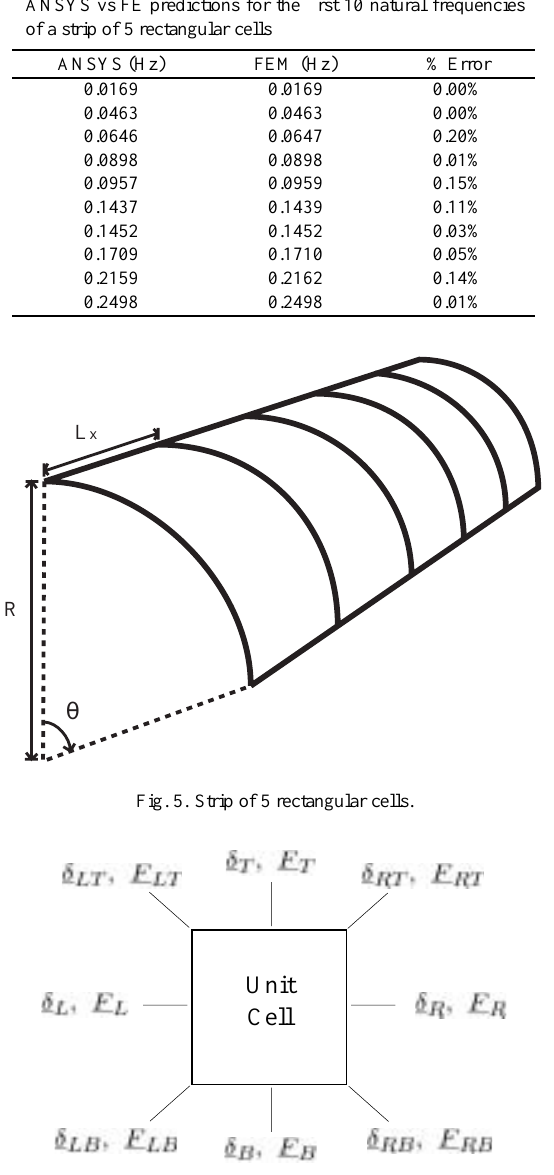
Fig. 6. Generalized nodal displacements and forces on a unit